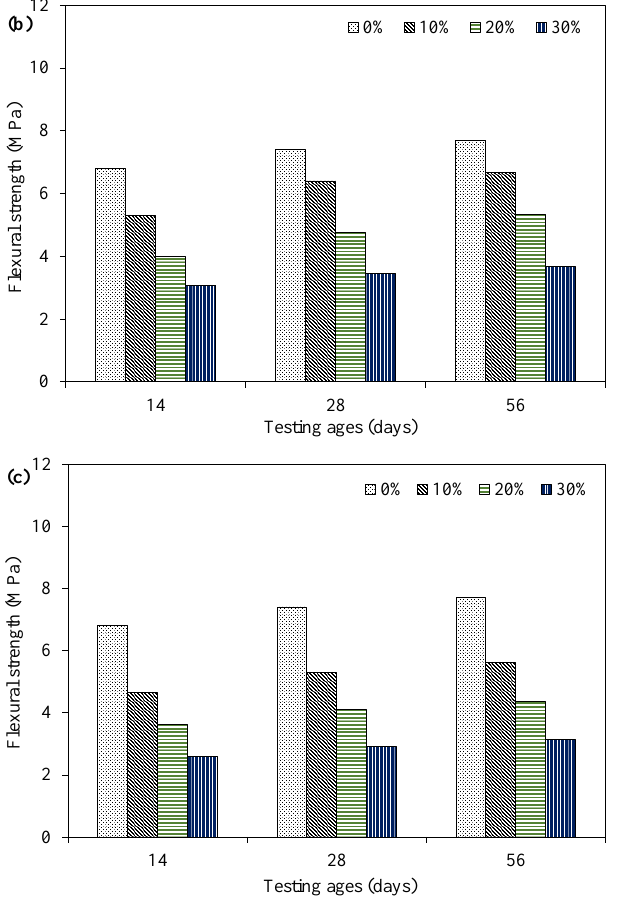
Figure 12. Flexural strength results for specimens incorporating various dosages of rubber: ( a ) R1, ( b ) R5, ( c ) R10.